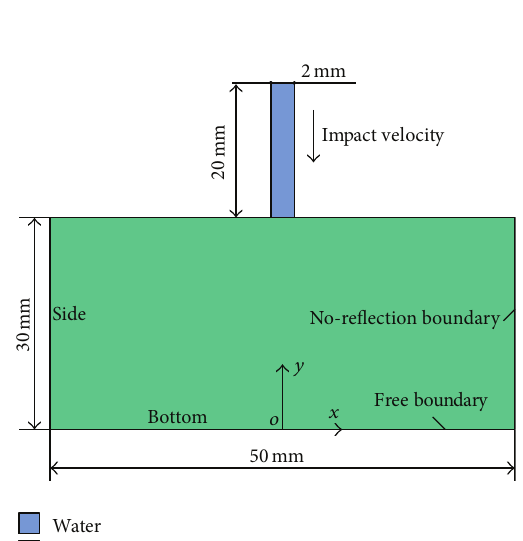
Figure 1: Coupled SPH/FEM method.